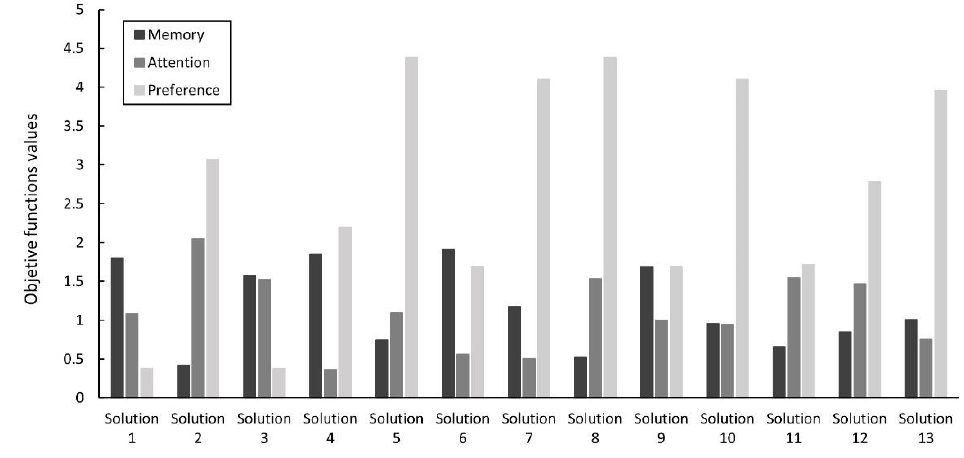
Figure 2. Three-dimensional graph of the efficient solution set.